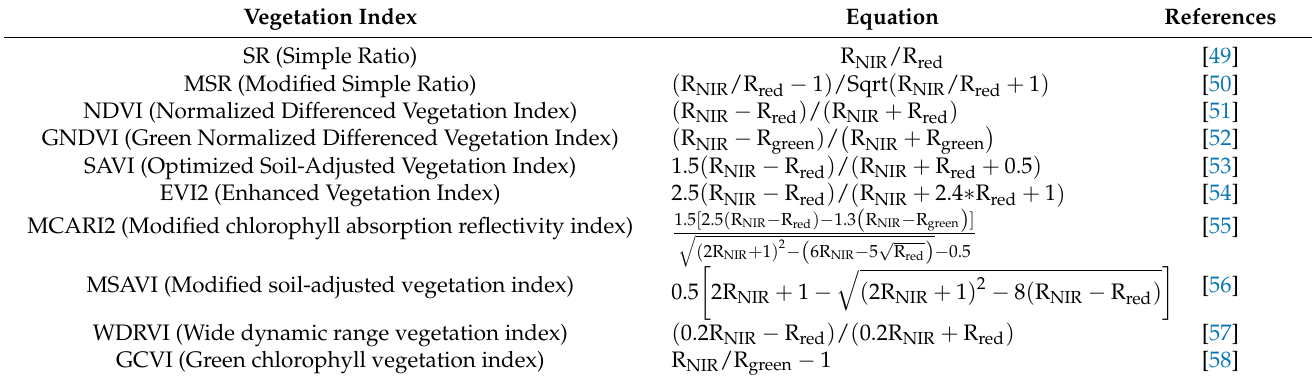
Table 2. VIs calculated using satellite imagery, where R is the reflectance of each band. Vegetation